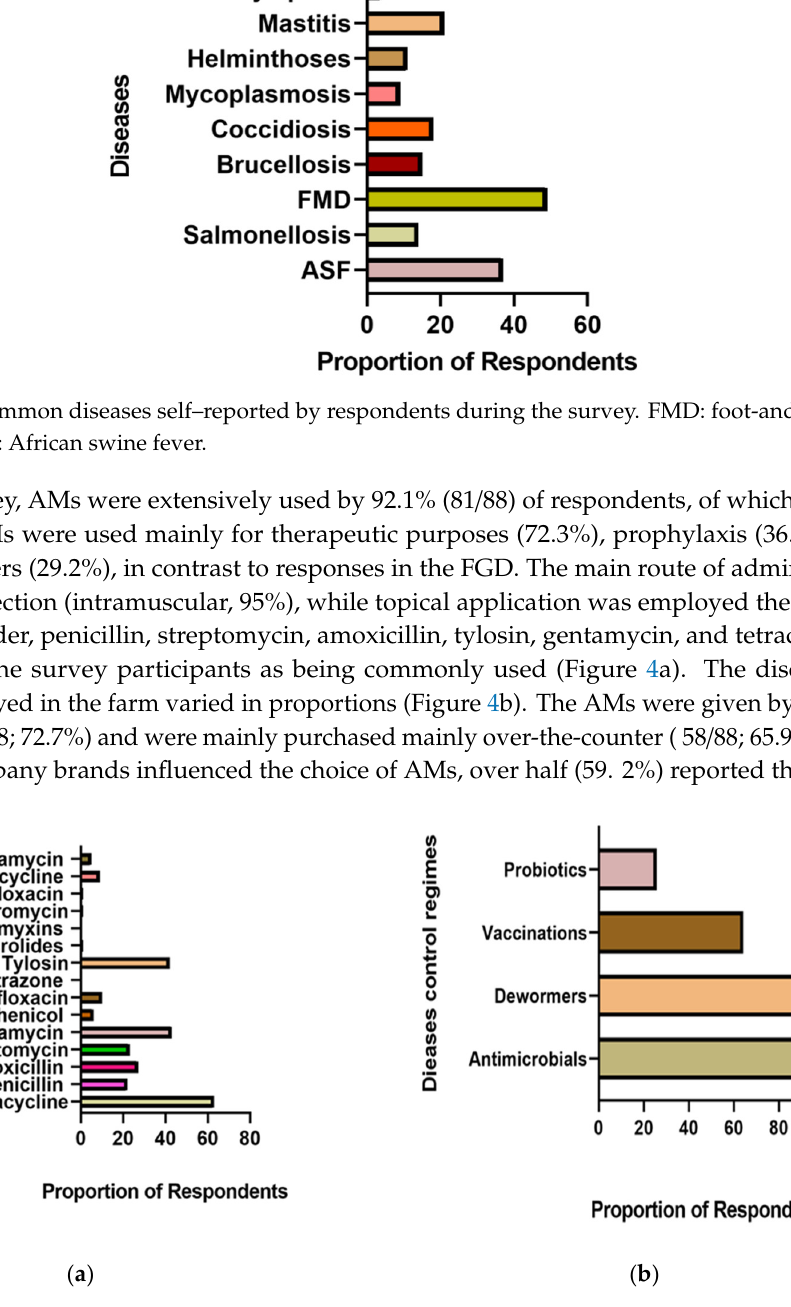
Figure 4. Common antimicrobials used by farmers and disease control regimens. ( a ) Self-reported AMs used by respondents in the treatment of pig diseases; ( b ) Various disease control regimens employed by pig farmers who participated in the